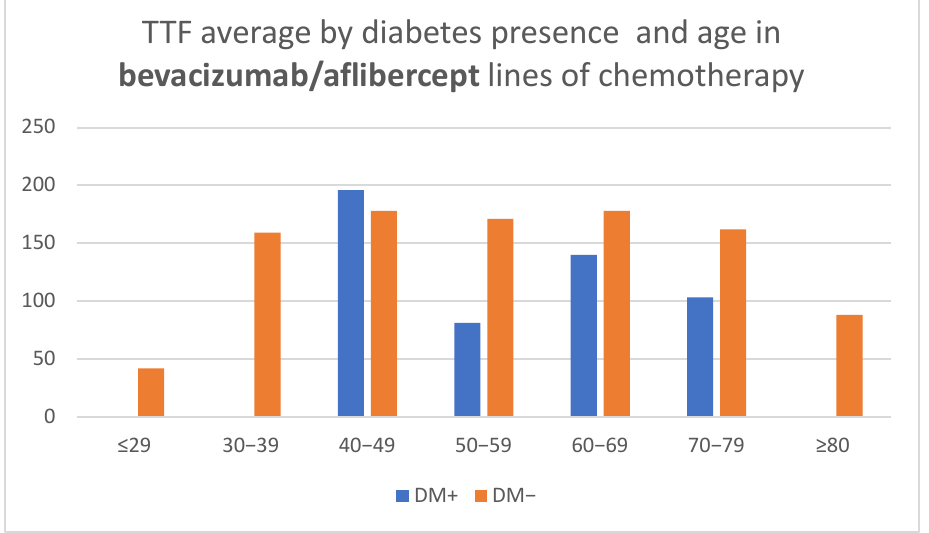
Figure 5. Time to treatment failure (TTF) average by diabetes presence and age in bevaci- zumab/aflibercept lines of chemotherapy .